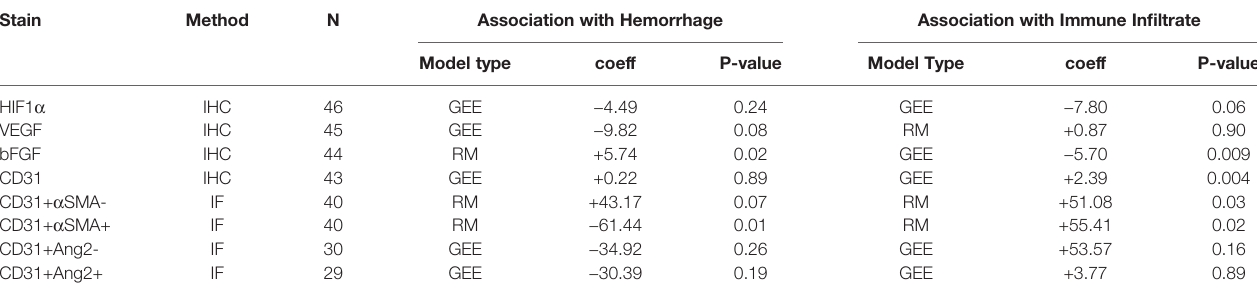
TABLE 4 | Correlation between various parameters within the melanoma compartment and intratumoral hemorrhage or tumor in fi ltrated lymphocytic density in melanoma brain metastases (University of Pittsburgh Medical Center cohort).